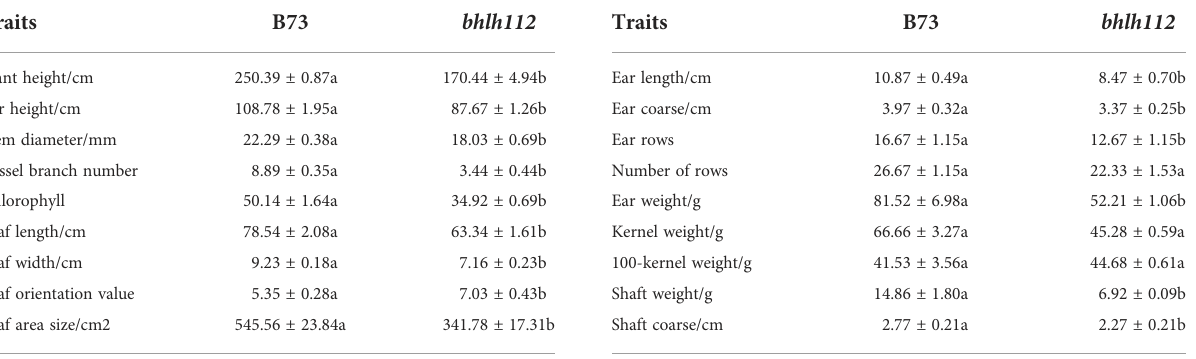
TABLE 2 Field phenotypic traits of mutant bhlh112 and B73. TABLE 3 Field grain traits of mutant bhlh112 and B73.